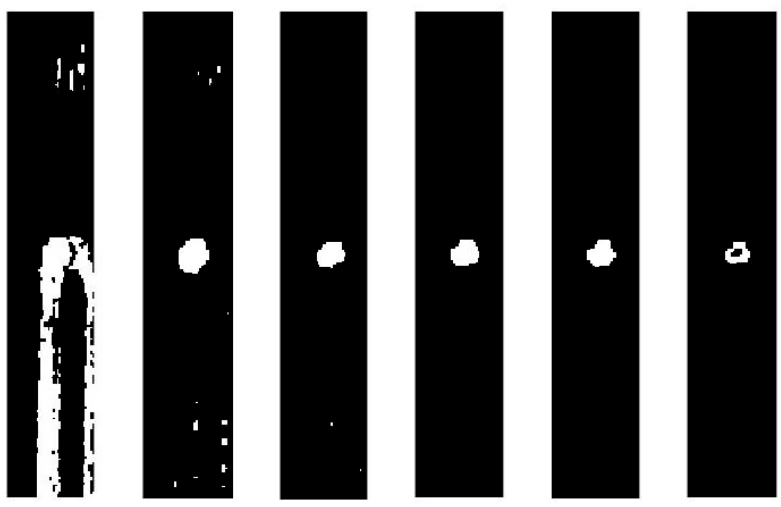
Figure 4. The sphere identification by changing values of the intensity threshold used to convert a negative image into a binary one. Threshold values in this picture vary (left to right) every 0.1 from 0.47 to 0.97 times the white level of 255.